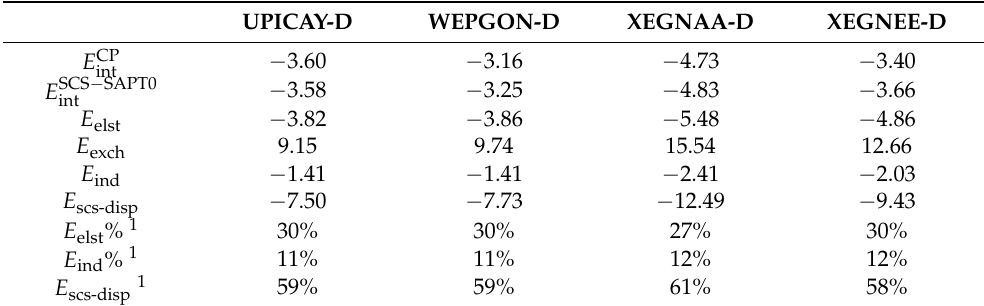
Energy decomposition of the SCS-SAPT0/aug-cc-pVDZ total interaction energies ( E SCS − SAPT0 ) for the dimers studied. The PBE0-D3(BJ)/def2-TZVPP total interaction energies ( E CP int are listed for comparison. All energy values are given in kcal/mol. UPICAY-D WEPGON-D XEGNAA-D